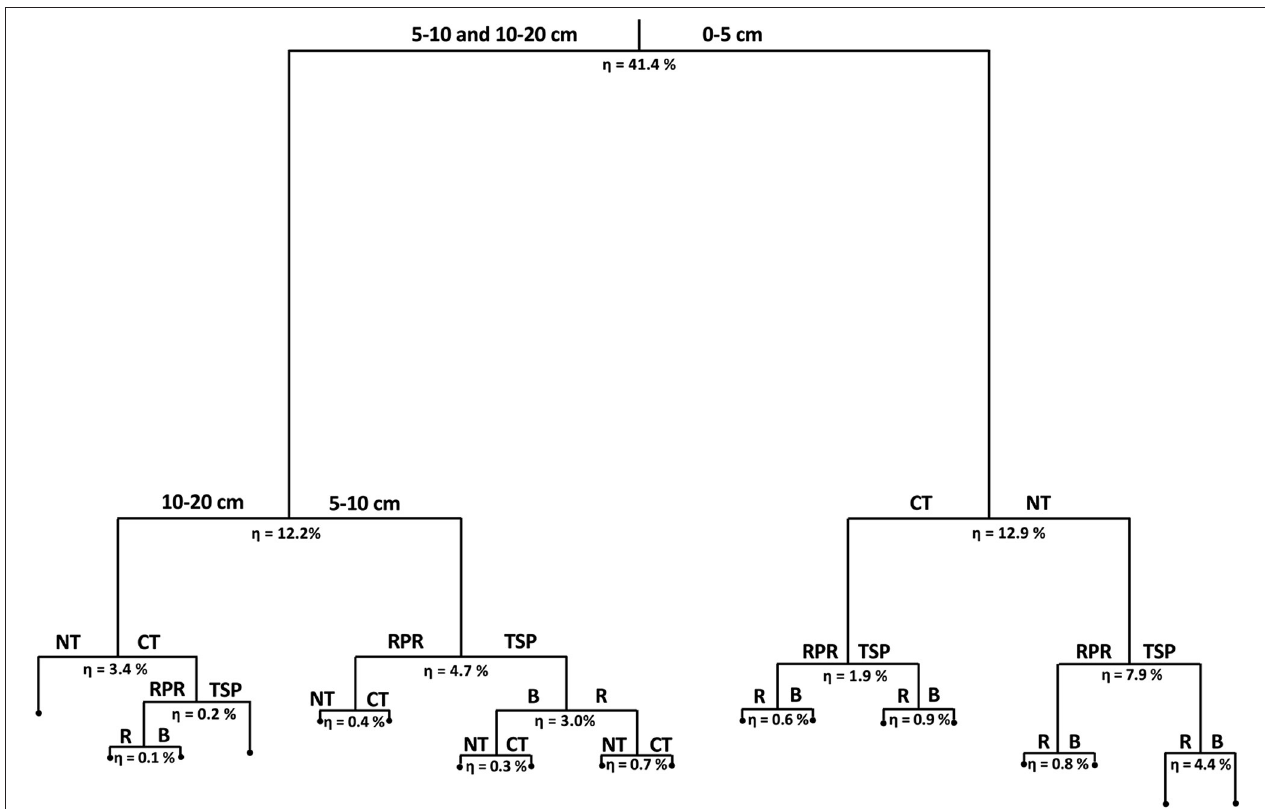
FIGURE 6 | Tree model for soil P availability and surface density of soybean and corn roots at different sampling layers (0–5cm, 5–10, and 10–20cm), soil tillage system (conventional tillage—CT and no-tillage—NT), source of phosphorus (triple superphosphate—TSP and reactive phosphate rock—RPR) and application modes (broadcast—B and row—R). η indicates the percent fraction of the total variability explained by each